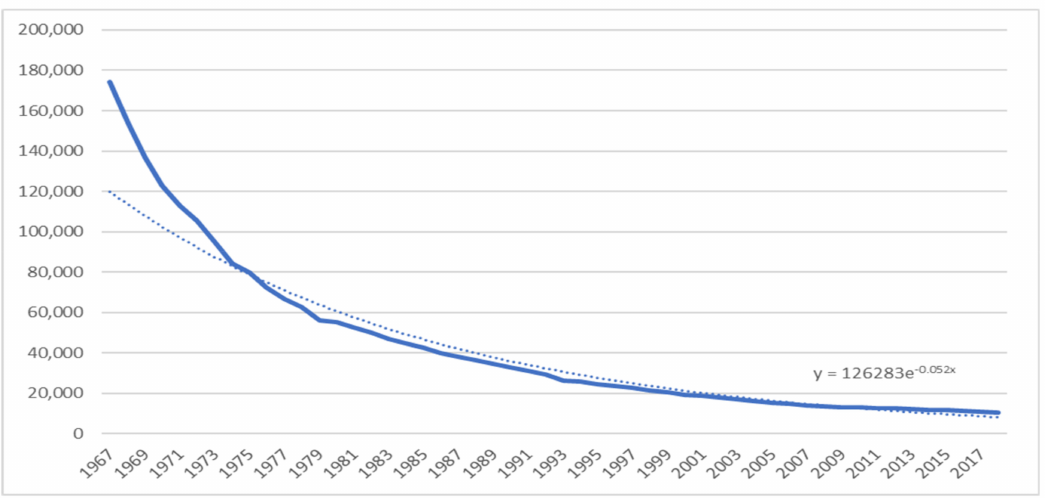
Figure 4. Number of Dairy Farms in Canada (1967 to 2018). Source: Canadian Dairy Information Center,